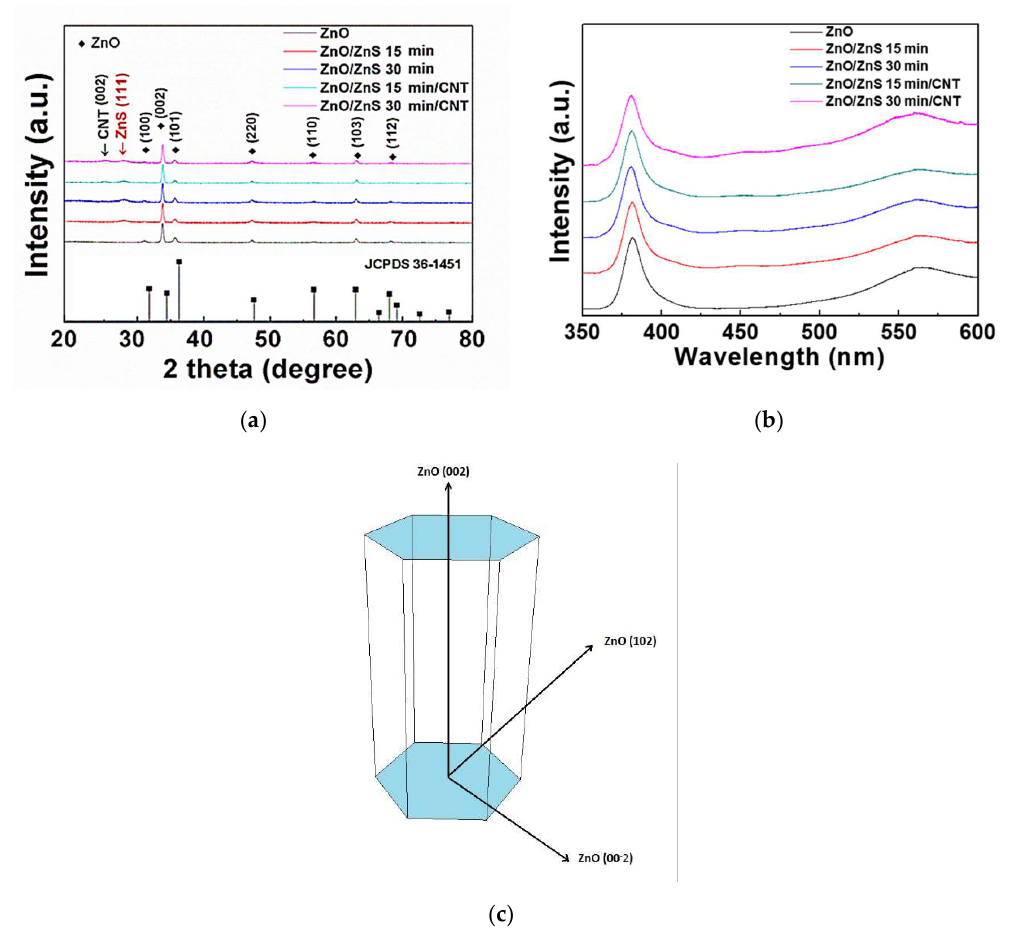
Figure 3. ( a ) XRD patterns of ZnO / ZnS core–shell structures and ZnO / ZnS / CNT nanocomposites; ( b ) photoluminescence (PL) measurements of ZnO / ZnS core–shell structures and ZnO / ZnS / CNT nanocomposites with various sulfurization periods; ( c ) Several orientations of hexagonal zinc oxide